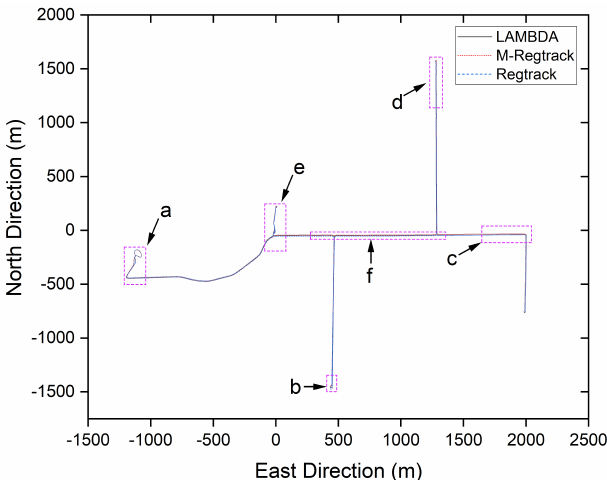
Figure 8. The trajectory tracking result for one rover receiver towards a static receiver without knowing the precise coordinates of the static one, where a–f indicates Figure 9a–f, respectively.